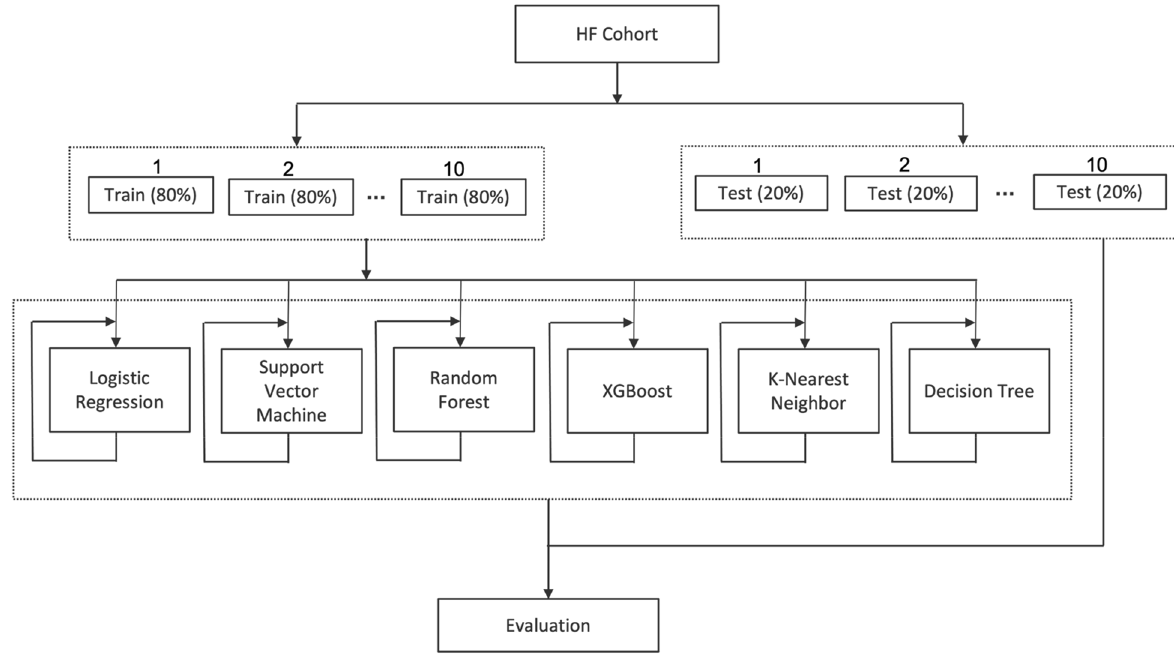
Figure 4. ML models’